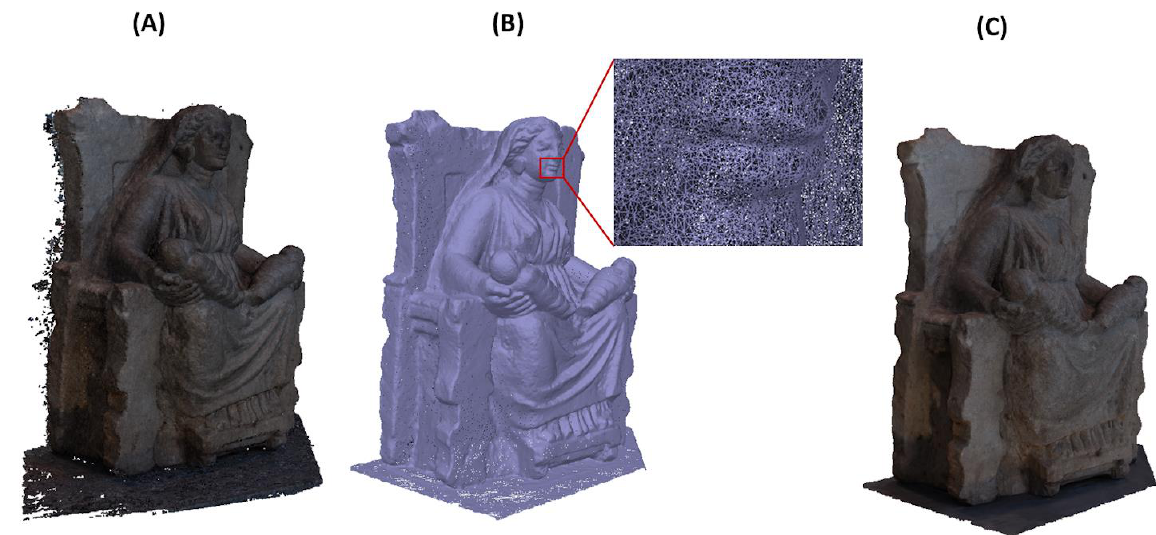
Figure 8. Initial dense point cloud model ( A ), mesh model ( B ), and textured model ( C ) resulting from photogrammetry after the mesh editing phase.